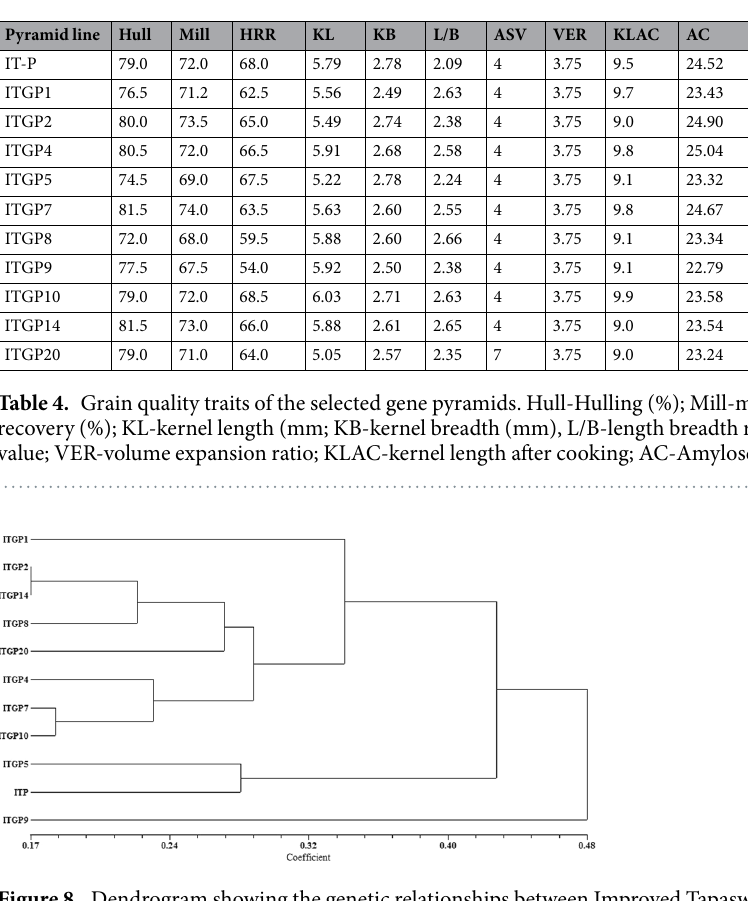
Of the 600 SSR markers screened, 44 markers showed polymorphism (Supplementary Table 1). From the 32 lines available at the BC 3 F 3 generation, based on the SSR background selection, 10 gene pyramids having closer similarity to the recurrent parent were selected. In the ten gene pyramids and the recurrent parent, a total of 69 amplicons were amplified with the number of alleles were in the range of 1–3 and the mean PIC value of all mark- ers was 0.20 with a highest value of 0.87 (RM5711) and a lowest value of 0.07 (RM1278) (Supplementary Table 1). The gene combinations of the selected gene pyramids are: Four gene pyramids (ITGP1, ITGP2, ITGP4, ITGP5) with all ten target genes/QTLs ( Xa4 + xa5 + xa13 + Xa21 + Gm1 + Gm4 + Pi2 + Pi9 + Sub1 + Saltol ), one (ITGP 7) with 8 genes/QTLs ( Xa4 + xa5 + xa13 + Xa21 + Gm1 + Gm4 + Sub1 + Saltol ), one (ITGP 8) with 7 genes/QTLs ( Xa4 + xa5 + xa13 + Xa21 + Pi2 + Sub1 + Saltol ) and four (ITGP9, ITGP1, ITGP14, ITGP20) with 6 genes/QTLs ( Xa4 + xa5 + xa13 + Xa21 + Sub1 + Saltol ).